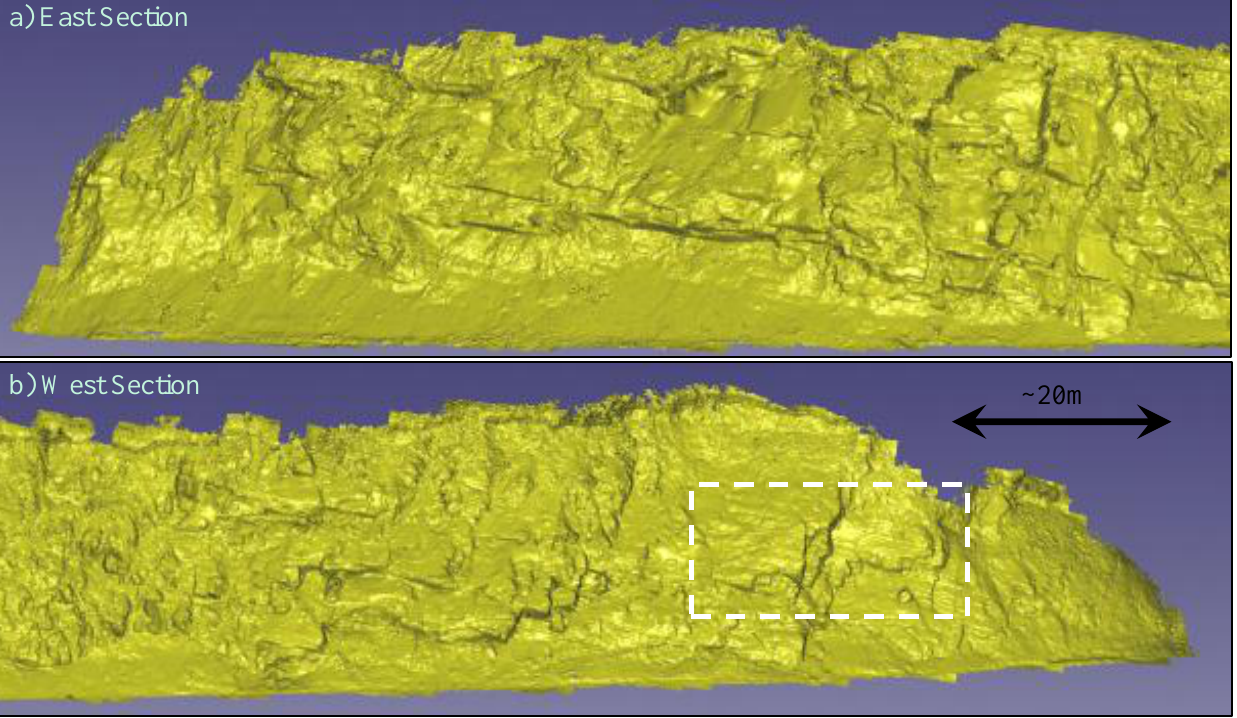
Figure 12. Photograph of overhanging rock at Site B. The crest-to-toe vertical height of the slope is approximately 11